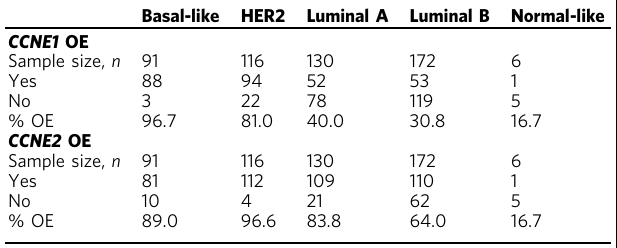
Table 2 Overexpression of CCNE1 and CCNE2 in